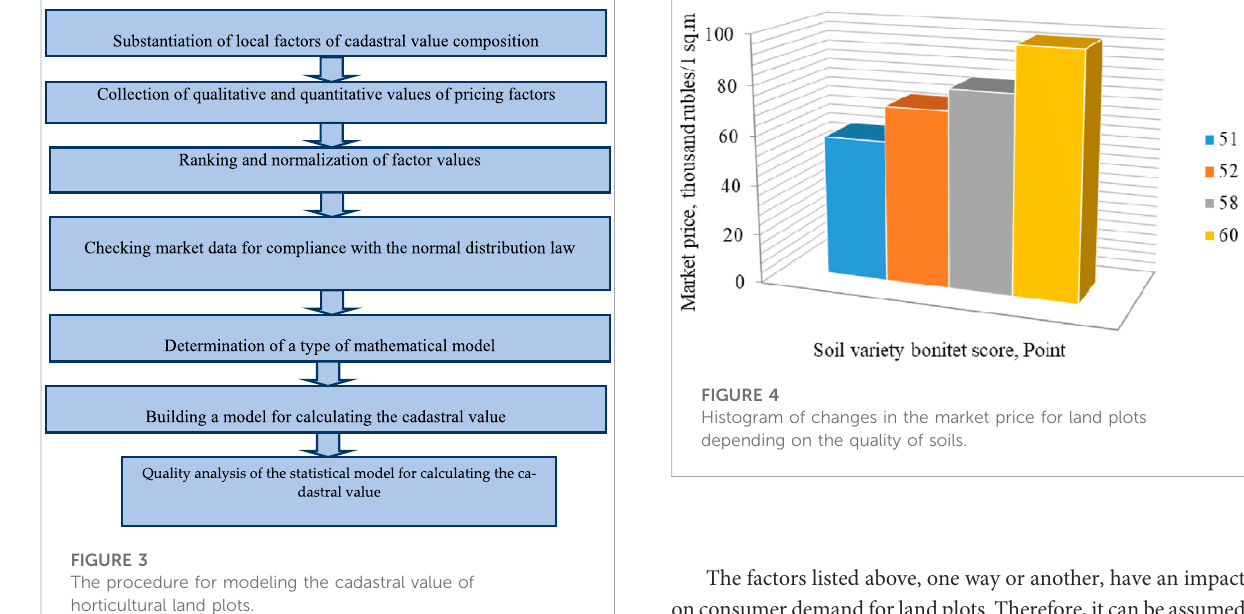
FIGURE 3 The procedure for modeling the cadastral value of horticultural land plots.